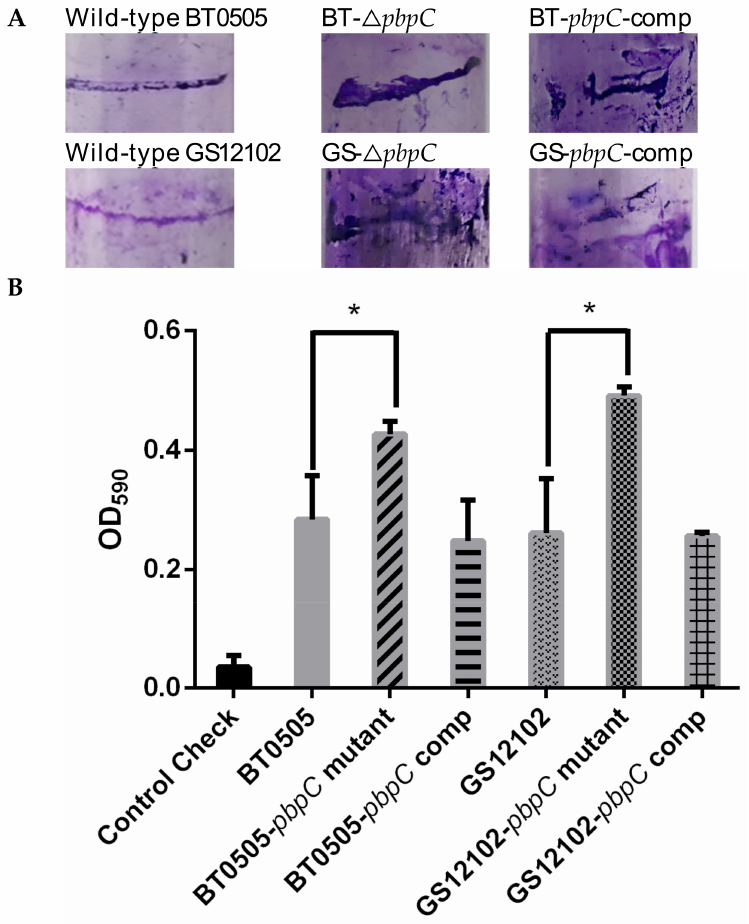
Figure 3. Evaluation of biofilm formation for wild-type, (cid:52) pbpC mutants, and pbpC -comp of C. michiganensis strains GS12102 and BT0505. ( A ) Images of biofilm formed in polystyrene culture tubes characterized by stained crystal violet fringes around the tube wall. ( B ) Biofilm quantification followed with ethanol washing of crystal violet and spectrophotometer measurements at optical density 590 (OD = 590 nm). Data are presented as means with standard error. Asterisks (*) indicate significant differences between wild-type strains and (cid:52) pbpC mutants as calculated by ANOVA ( p < 0.05, n = 6). Error bars indicate standard deviation